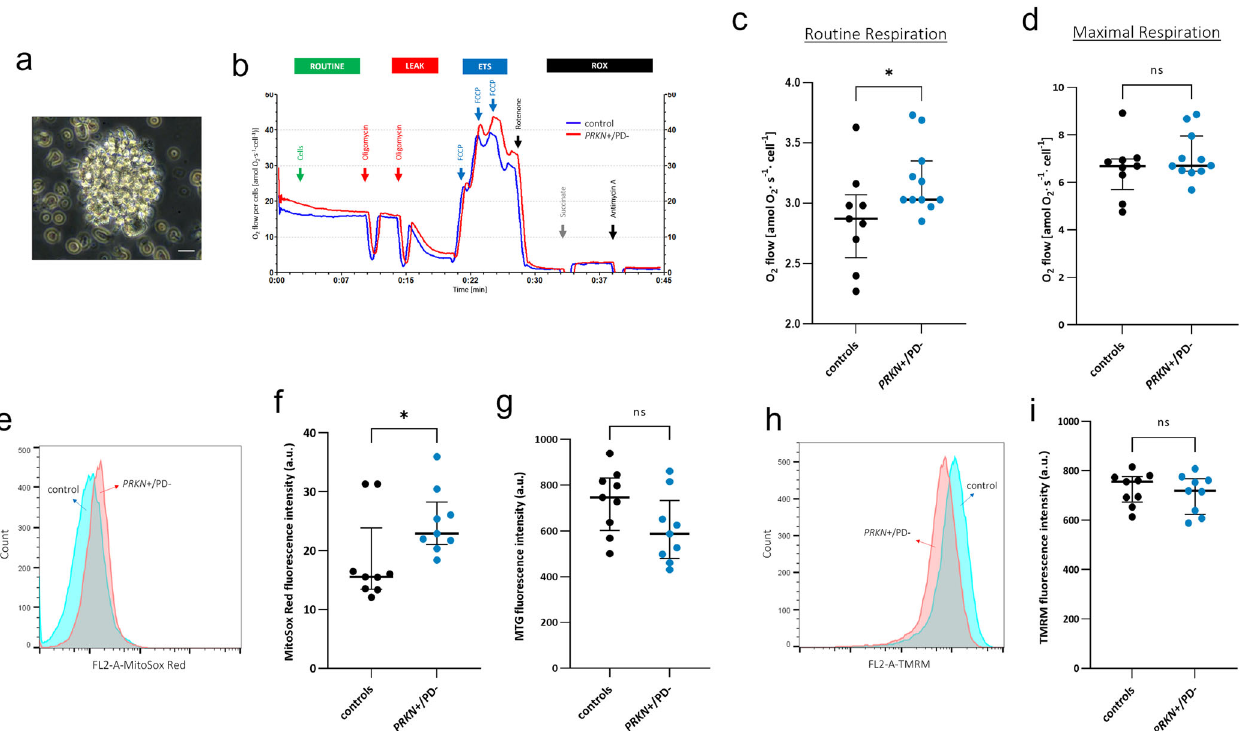
Fig. 2 Altered mitochondrial function in LCLs of heterozygous PRKN variant carriers. a Visualization of LCLs by phase contrast inverted microscope: cell clump showing typical rosette morphology, scale bar: 25 µm. b Representative traces of real-time high-resolution respirometry using an intact substrate-uncoupler-inhibitor titration (SUIT) protocol. The oxygen fl ow per cells (y-axis) is represented as a function of time (x-axis). Arrows indicate the addition of cells and titrations of substrates and inhibitors, which comprised: the addition of 5 × 10 − 6 cells in each chamber; oligomycin (5 nM each step); FCCP (0.5 µM each step); rotenone (0.5 µM); succinate (10 mM); antimycin A (2.5 µM). Representative trace for one control (blue trace) and one heterozygous exon 7 deletion carrier (red trace). Oxygen fl uxes were normalized for cell count and citrate synthase activity. ETS electron transfer system; ROX residual oxygen consumption. Group-wise comparison of routine respiration ( c ) and maximal respiration ( d ) in LCLs from exon 7 heterozygous deletion carriers ( PRKN + /PD − , n = 11) and controls ( n = 9), characterized by mitochondrial oxygen fl ow per cell. Each line was measured in n ≥ 3 independent assays. Data were presented as scatter plots showing a median with an interquartile range. Statistical analysis was carried out by using the Mann – Whitney U - test. (*) indicates signi fi cant group differences with an alpha level of 0.05. p = 0.023; ns not signi fi cant. e Representative fl ow cytometry histograms of MitoSox Red fl uorescence in LCLs (20,000 cells). f Group-wise comparison of mROS production in LCLs of heterozygous